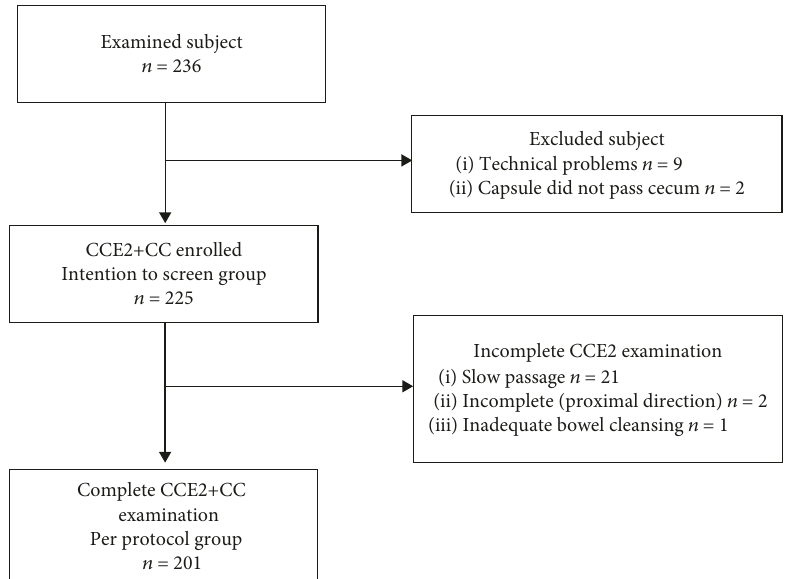
Figure 2: STARD fl owchart (STAndards for the Reporting of Diagnostic accuracy studies) of the patients ’ enrollment in the study. CCE2: second-generation colon capsule endoscopy; CC: conventional colonoscopy. Table 3: Accuracy of CCE2 in colorectal neoplasia detection (per-patient analysis, intention-to-screen group, N = 225 ). Colonoscopy Colonic capsule